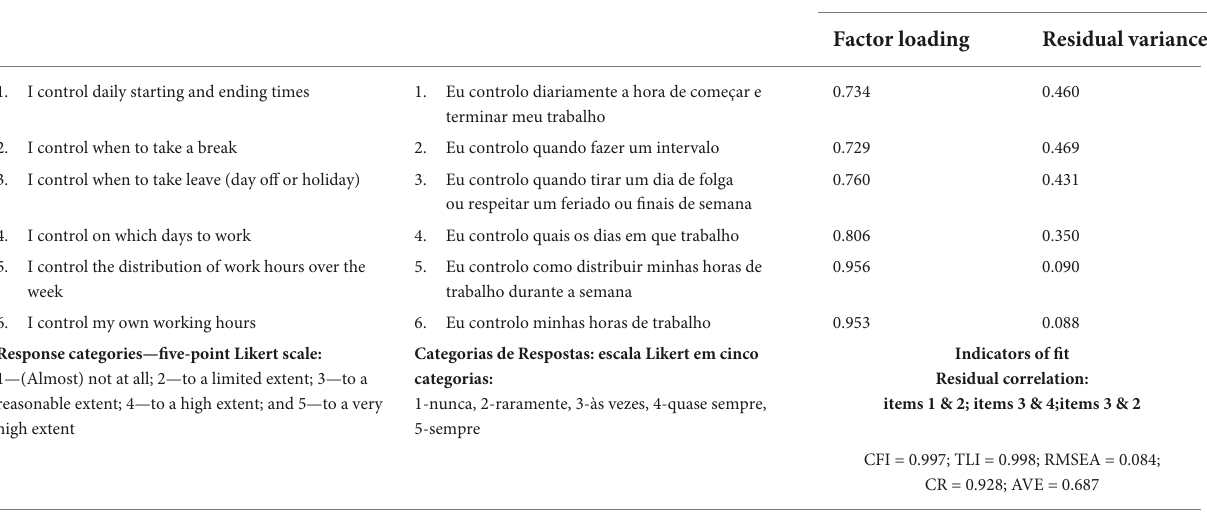
TABLE 1 Items in the work time control scale, original version in English, version in Brazilian Portuguese, and results of the confirmatory factor analysis. Items of the original scale